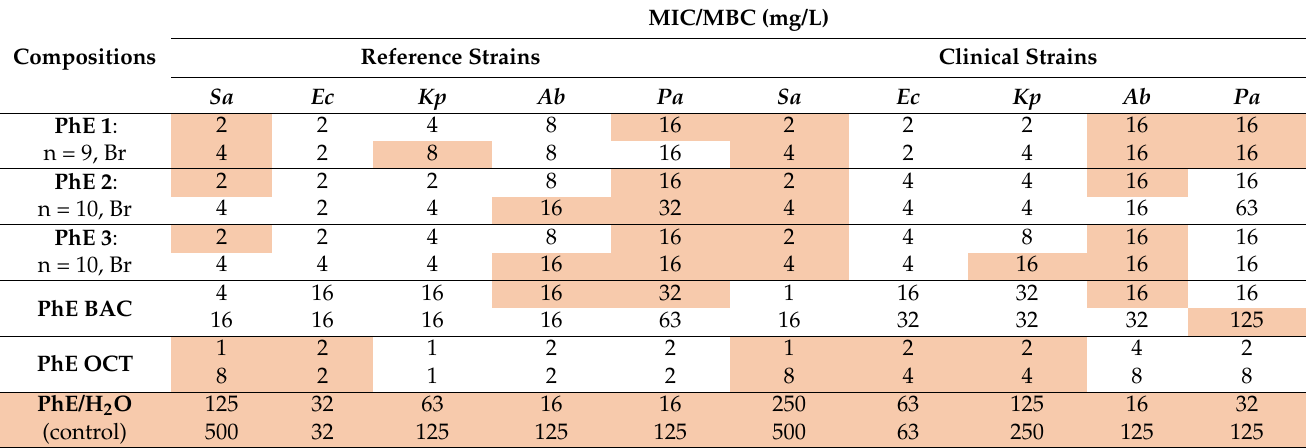
Table 4. Antibacterial activity of QACs with different alcohols against planktonic